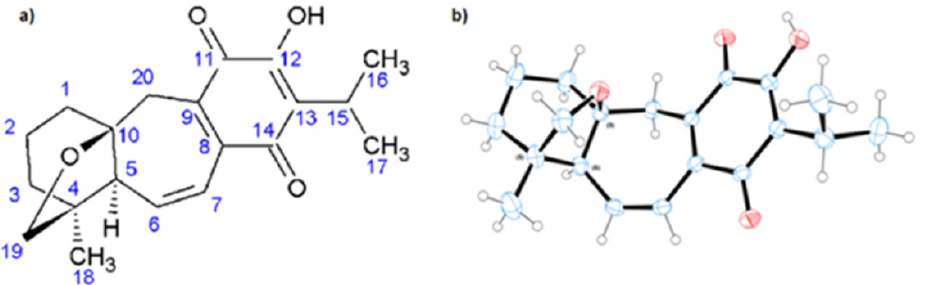
Figure 1. ( a ) Structure of 19-deoxyicetexone. ( b ) X-ray ORTEP diagram of 19-deoxyicetexone.